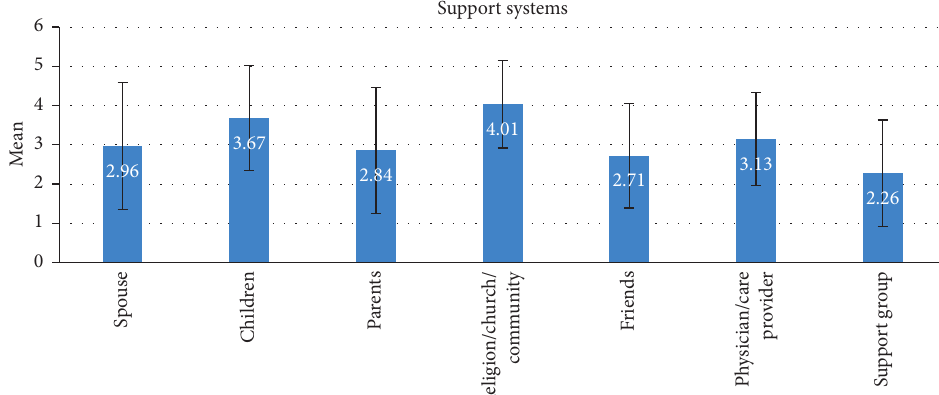
Figure 1: Support systems in coping with breast cancer. Error bars � standard deviation; response: 1 � strongly disagree; 2 � disagree; 3 � neutral; 4 � agree; 5 � strongly agree.